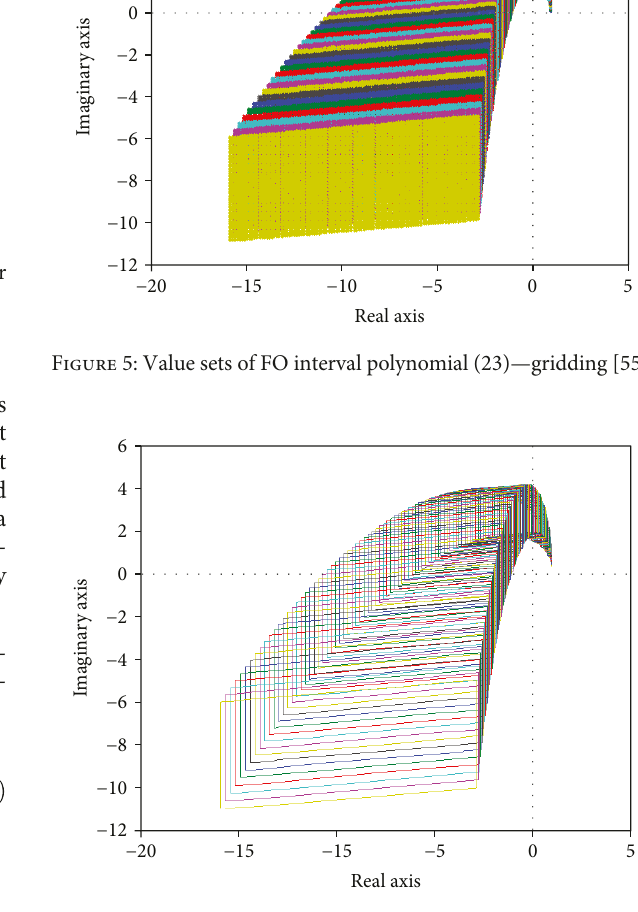
Figure 6: Value sets of FO interval polynomial (23) — convex hulls